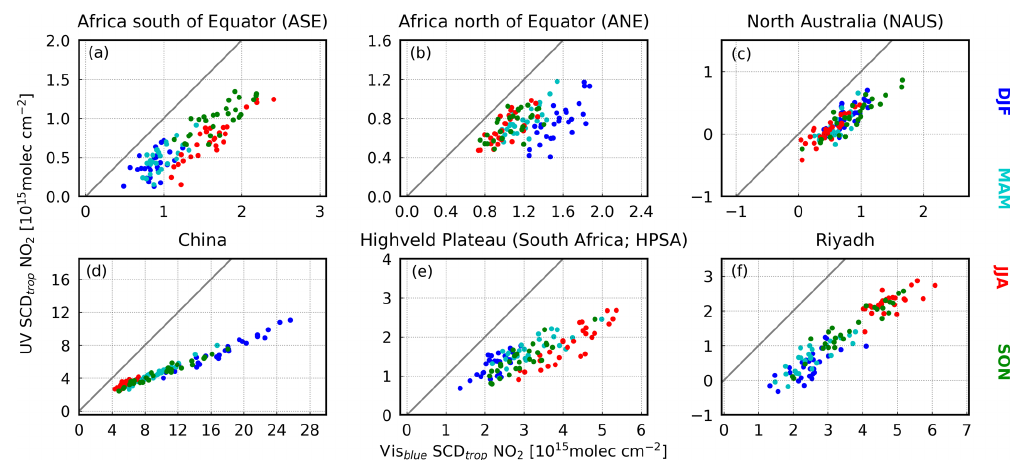
Figure 12. Scatter plot of tropospheric UV NO 2 SCDs against tropospheric vis blue NO 2 SCDs for the period 2007–2015 for the six selected regions. Note the different axes. The seasons are colour-coded. The related correlation, slope, and intercept of the regression line can be found in Tables 4 and 5. December, January, February: DJF; March, April, May: MAM; June, July, August: JJA; September, October, November: